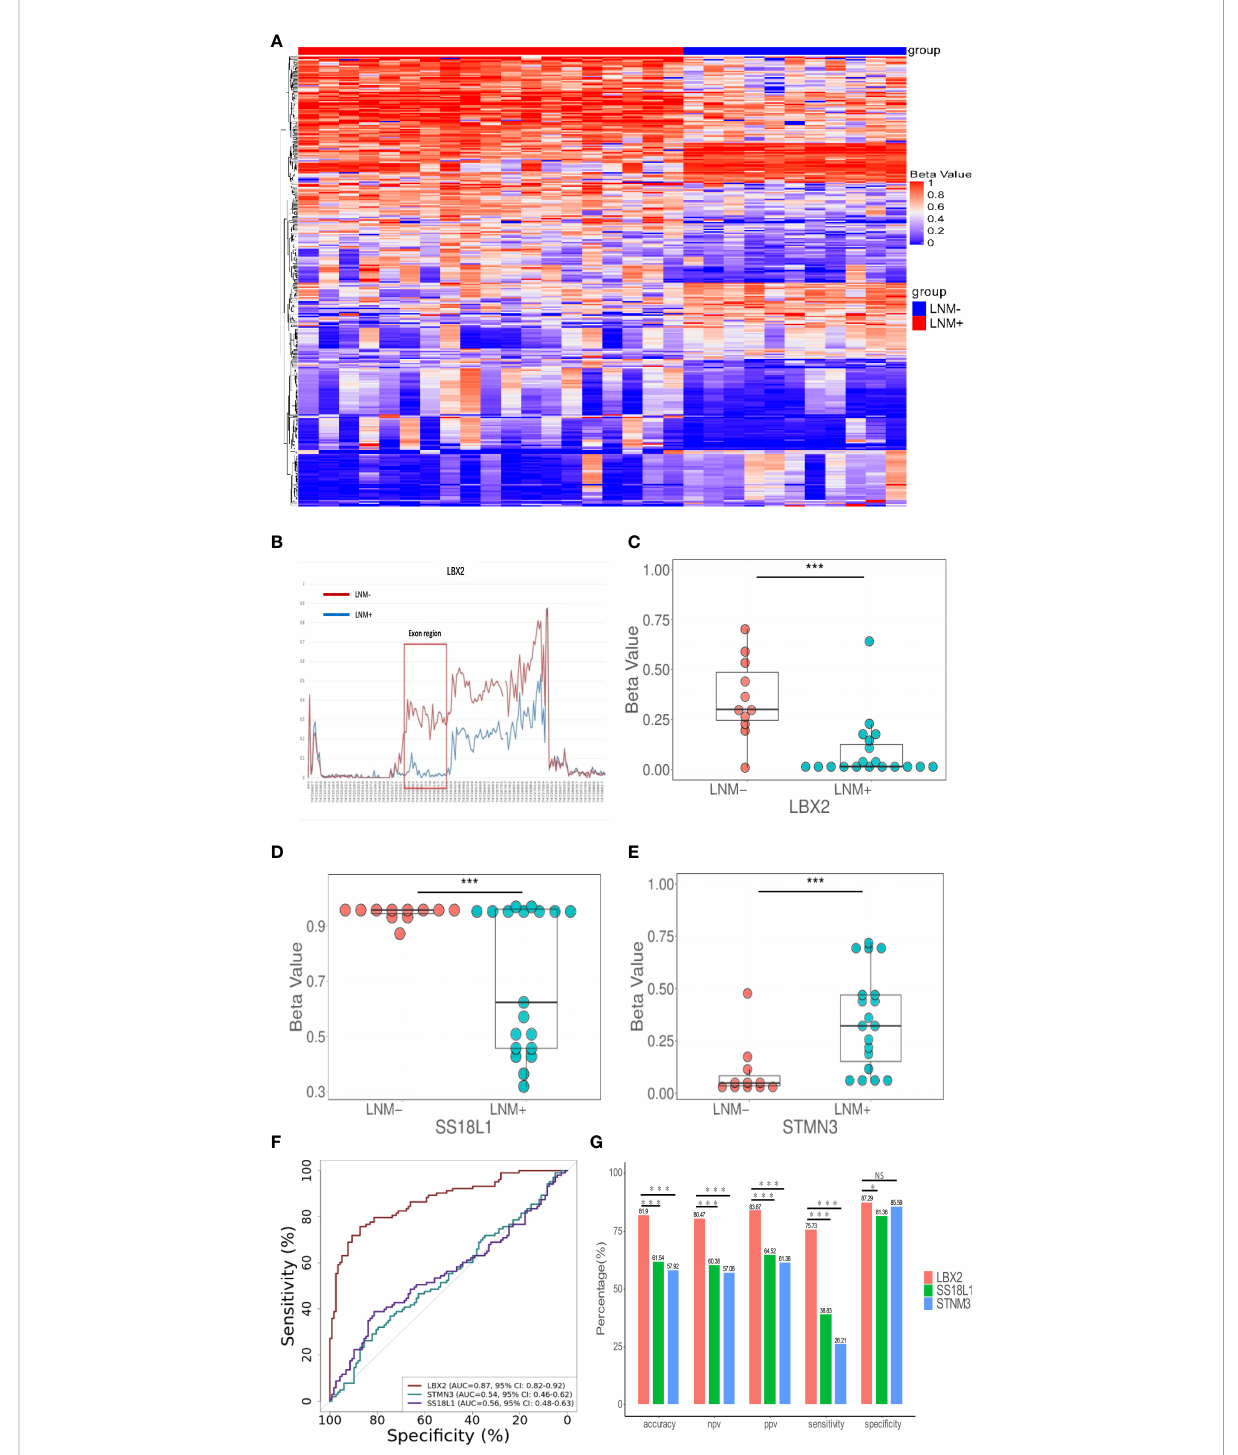
FIGURE 2 ThediscoveryofDNAmethylationmarkerstodetectLNMinCRCtissue. (A) Inthediscoverycohort,anunsupervisedhierarchicalclusteranalysiswasbasedon differentialmethylationbetweenLNM+(n=19)andLNM-(n=11),witheachcolumnrepresentingapatientandeachrowrepresentingaCpGmarker. (B) Methylationlevelsofexonregionof LBX2 inLNM-andLNM+groupsinCRC (C-E) .Themethylationleveldistributionof LBX2,STMN3 ,and SS18L1 between LNM+(n=19)andLNM-(n=11)wasrepresentedbythe b valuefromgenome-widemethylationsequencinginthediscoverycohort. (F) ROCcurveofthree methylationmarkers.TheeffectivenessofthreeDNAmethylationmethodswasevaluatedbycomparingAUCvalues. (G) Theaccuracy,NPV,PPV,sensitivity andspeci fi cityofthreemethylationmarkerwerecomparedrespectively.*p<0.05,**p<0.01and***p<0.001.NS,notstatisticallysigni fi